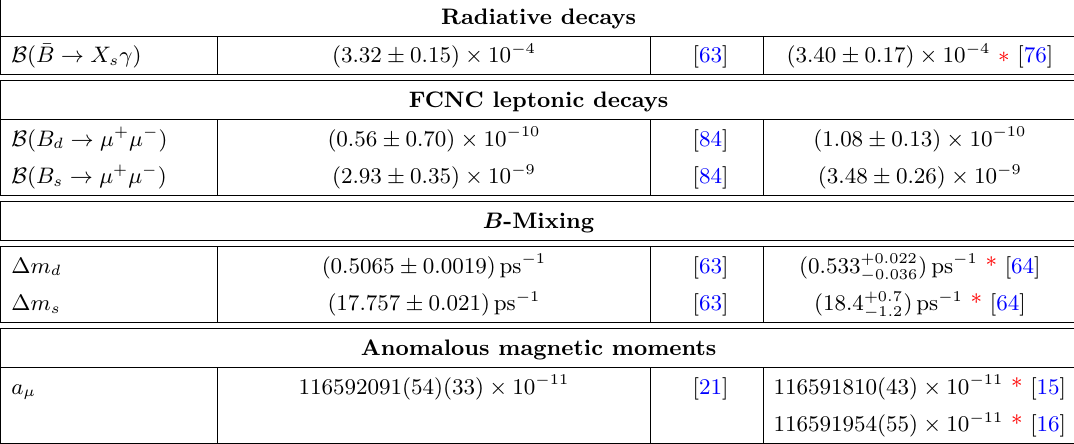
Table 6. Table of flavour observables (except b → s‘ + ‘ − ) used in the analysis. The stated SM predictions are our calculations through flavio , where we have modified some appropriately in order to closely replicate the most recent averages or predictions, for example in B -mixing and B → X s γ (marked by ∗ in the fourth